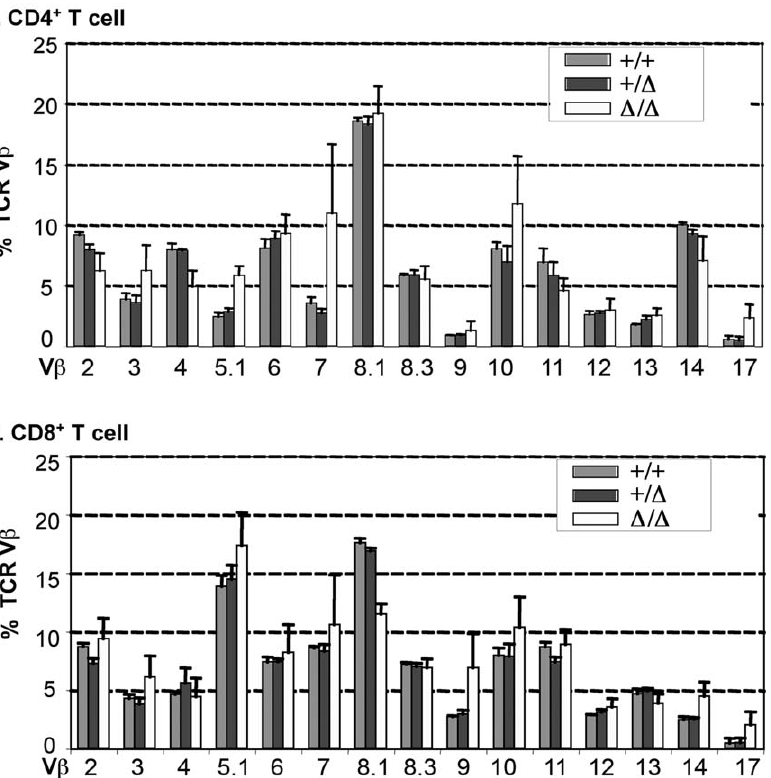
Figure 1. TCR V b usage in the peripheral T cells of Foxn1 D / D mutant mice. The peripheral cells from spleen and LNs were screened with TCR V b usage. The result shown was average volume from at least 5 individual samples. A and B show the percentage of expression of TCR V b s on CD4 and CD8 T cells.